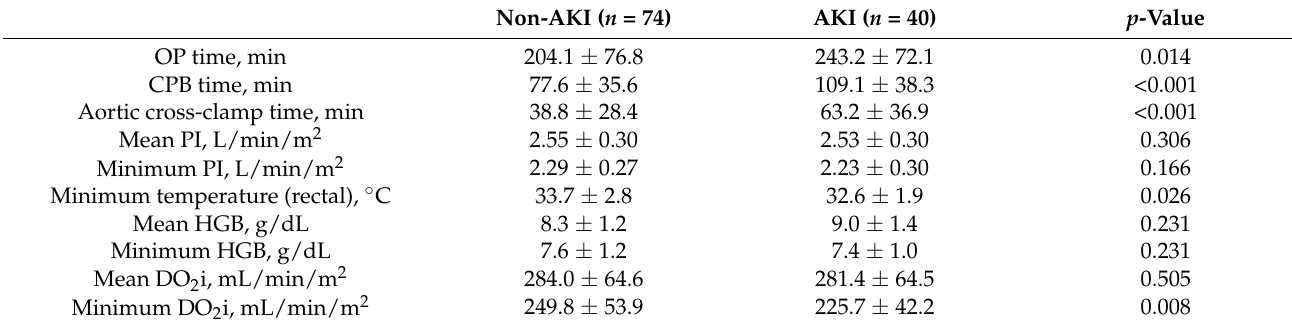
Table 3. Comparison of intraoperative clinical data.